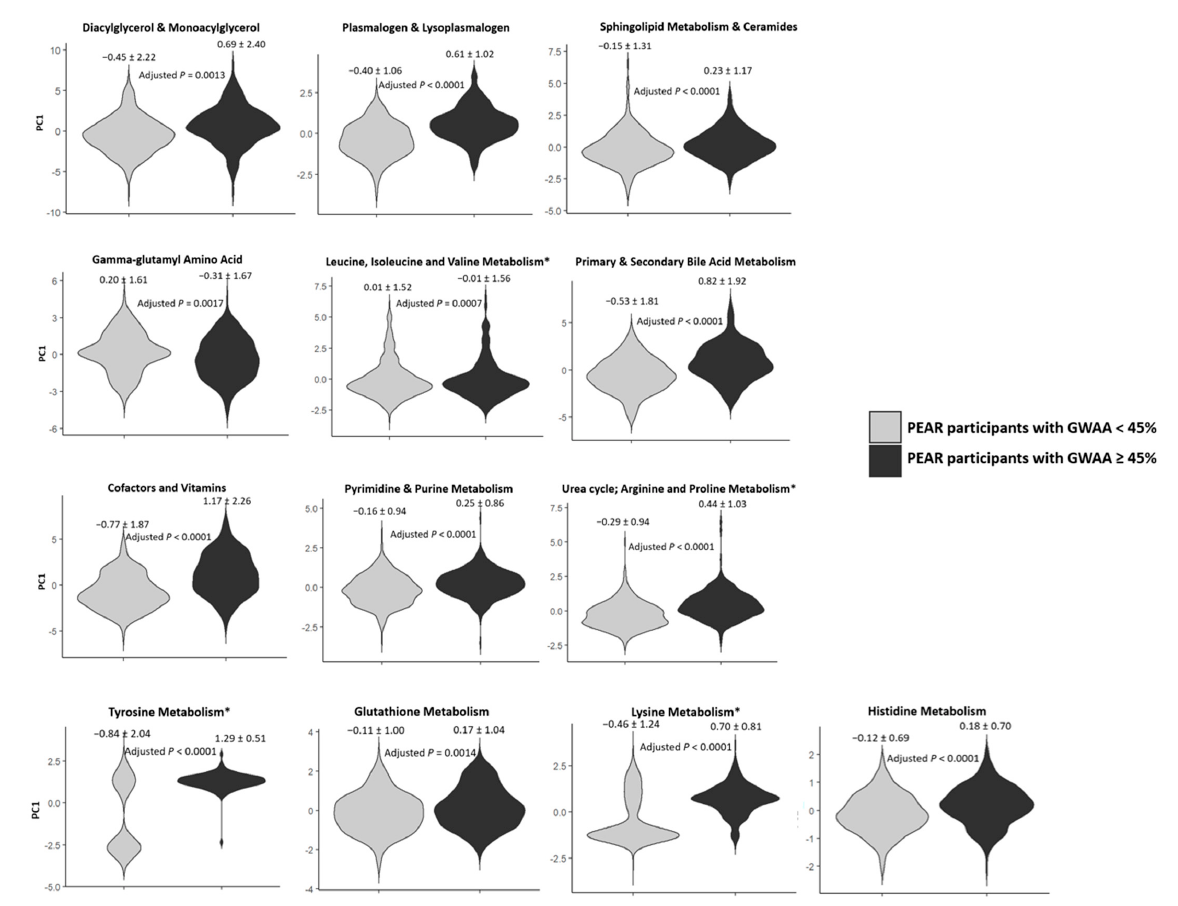
Figure 2. Violin plots comparing PC1 values of each of the 13 significant metabolic clusters between PEAR participants with GWAA < 45% and those with GWAA ≥ 45%. Gray bars represent PEAR participants with GWAA < 45%, whereas the black bars represent PEAR participants with GWAA ≥ 45%. The adjusted p -values (Bonferroni-corrected) were calculated using multivariable linear regression models adjusted for age, sex, recruitment site, baseline log-transformed PRA and batch effect. * Metabolic clusters with highly skewed or bimodal PC1 distribution ( n = 4) (flagged): leucine, isoleucine and valine metabolism; urea cycle/arginine and proline metabolism; tyrosine metabolism and lysine metabolism. Abbreviations: PC, principal component; PEAR, Pharmacogenomic Evaluation of Antihypertensive Responses; GWAA, Genetic West African